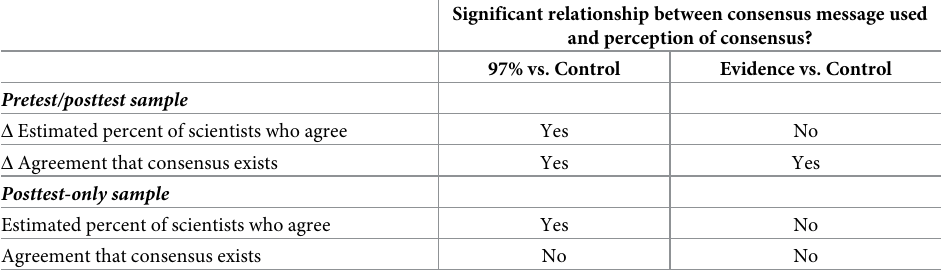
Unlike the results from the pretest/posttest sample, the results from the posttest-only sam- ple are more supportive of the hypothesis that there are effects of consensus messaging—at least when it comes to messages that describe a descriptive norm amongst authorities (i.e., 97% of medical scientists agree). Indeed, there were significant differences between the 97% mes- sage and the control message for four key variables: percent of scientists perceived to agree, belief that cannabis is an effective treatment for chronic pain, and support for legalizing medi- cal and recreational cannabis for those aged 21 years and older. Notably, these differences between the control condition and consensus message condition were not significant when the consensus message described substantial evidence (as opposed to a proportion of agreeing scientists). And in many cases, participants’ item ratings in the 97% message condition differed significantly from those in the evidence message condition. This leads to questions about whether participants are actually influenced by the consensus aspect of the message or some other characteristic that differs between the two types of consen- sus messages examined in this study (e.g., the presence of a number, a high percentage). Aligning the message strategy with the measurement design Sometimes the relationship between exposure to a consensus message and participants’ esti- mates of scientific consensus is not statistically significant when non-numeric messages are used [3, 8, 22]. Landrum and Slater [8] hypothesize that this may be due to a lack of alignment between the type of message used and the way the participants’ perceptions of scientific con- sensus is measured. For example, Bolsen and Druckman [23] found a significant relationship between exposure to a process-based consensus message (describing how consensus was formed from a National Academies of Sciences panel) and their measure of perception of sci- entific consensus (i.e., whether most scientists agree). We designed this study to answer this question by randomly assigning participants at posttest to two different forms of measurement for this question: one that asked them to estimate the percent of scientists who agree and one that asked them how much they agreed or disagreed that there is scientific consensus (see Table 1). We found mixed evidence regarding this hypothesis. See Table 2. Change in perceptions of scientific consensus between time 1 and time 2. First, we looked at change in perceptions of scientific consensus among the pretest/posttest sample. A 3 (Message Condition) by 2 (Measure) ANOVA suggests that there is a main effect of condition, F (2, 882) = 6.88, p = .001, η p2 = 0.02, but not an effect of Measure, F (1, 882) = 1.54, p = .215, η p2 = 0.002, or an interaction effect between condition and measure, F (2, 882) = 1.87, p = .155, η p2 = 0.004. Follow-up simple GLM analyses show that the relationships between condition Table 2. Is there a significant relationship between condition manipulation and participants’ perception of con- sensus based on consensus message strategy used and measurement? Significant relationship between consensus message used and perception of consensus? 97% vs. Control Evidence vs.